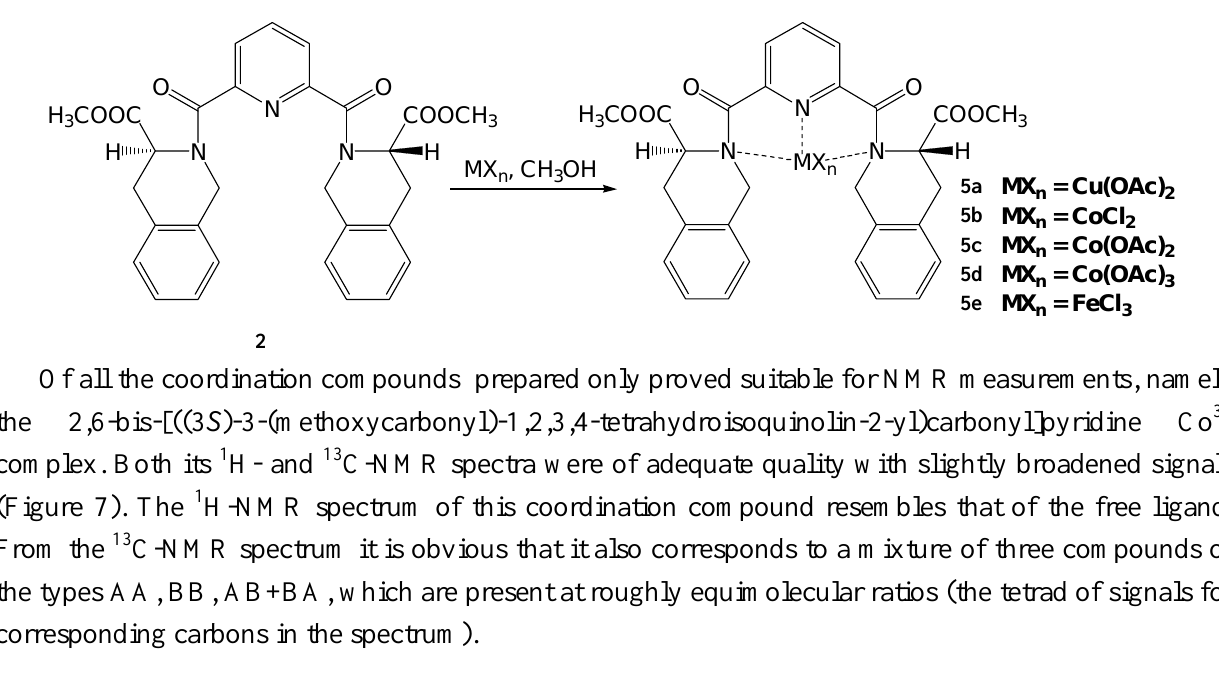
Figure 7. 500 MHz H-H COSY spectrum of the coordination compound 5d (Co 3+ 2,6- bis[((3 S )-3-(methoxycarbonyl)-1,2,3,4-tetrahydroisoquinolin-2-yl)carbonyl]pyridine) in DMSO-D 6